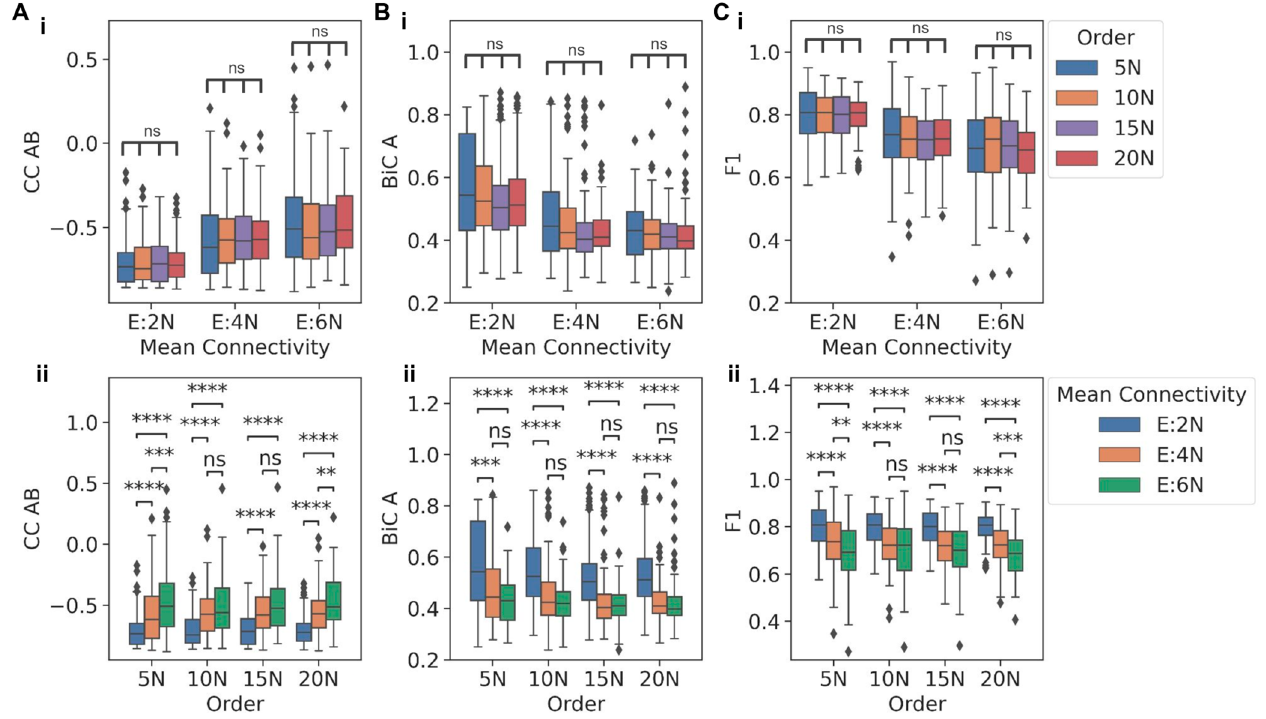
Figure 3. Functional traits of TS embedded in large networks. ( A ) Comparison between the distributions of CC AB for TS embedded in: (i) networks of same mean connectivity but having different orders and (ii) networks of same order having different mean connectivity. ( B ) Comparison between the distributions of BiC A for TS embedded in: (i) networks of same mean connectivity but having different orders and (ii) networks of same order having different mean connectivity. ( C ) Comparison between the distributions of F1 for TS embedded in: (i) networks of same mean connectivity but having different orders and (ii) networks of same order having different mean connectivity. p -values of pairwise Mann-Whitney U tests are denoted by: ns— p <= 1, *—0.01< p <= 0.05, **—0.001 < p <= 0.01, ***—0.0001 < p <= 0.001, ****— p <= 0.0001.